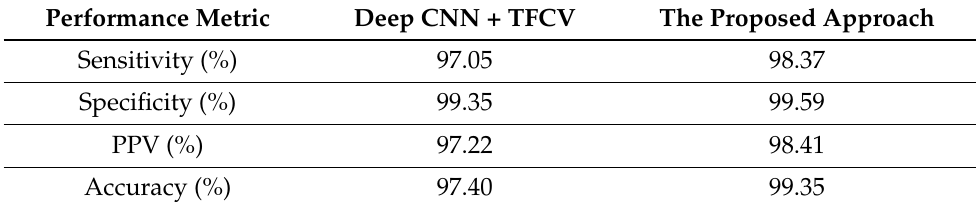
Table 15. Overall Results of the Performance Metrics on